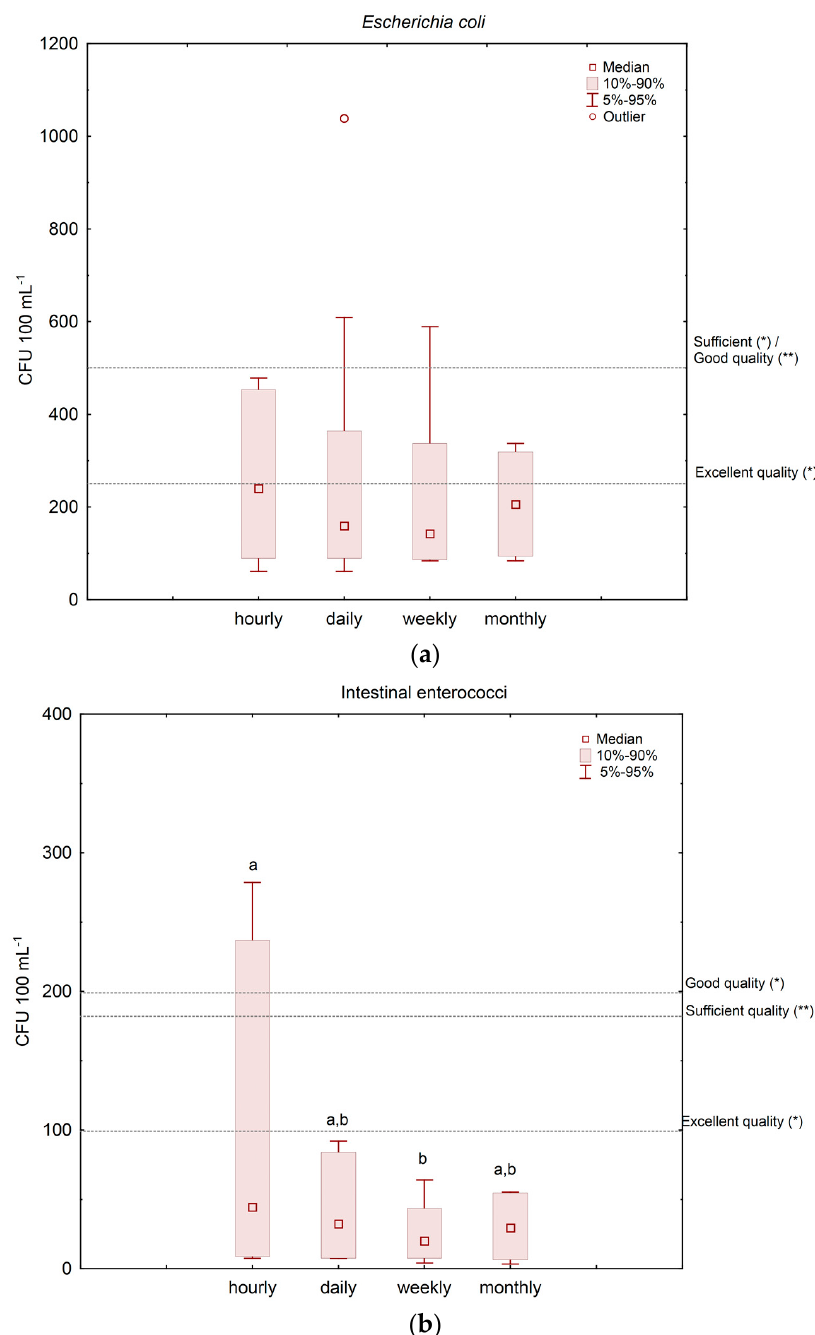
Figure 5. Temporal scale variances for the microbiological indicators: ( a ) E. coli ; ( b ) Intestinal enterococci, measured at Z2 BWD benchmarks are given (Sufficient/Good/Excellent quality; assessment based on * percentile 95; ** percentile 90). Letters correspond to different homogeneous groups derived from ANOVA.